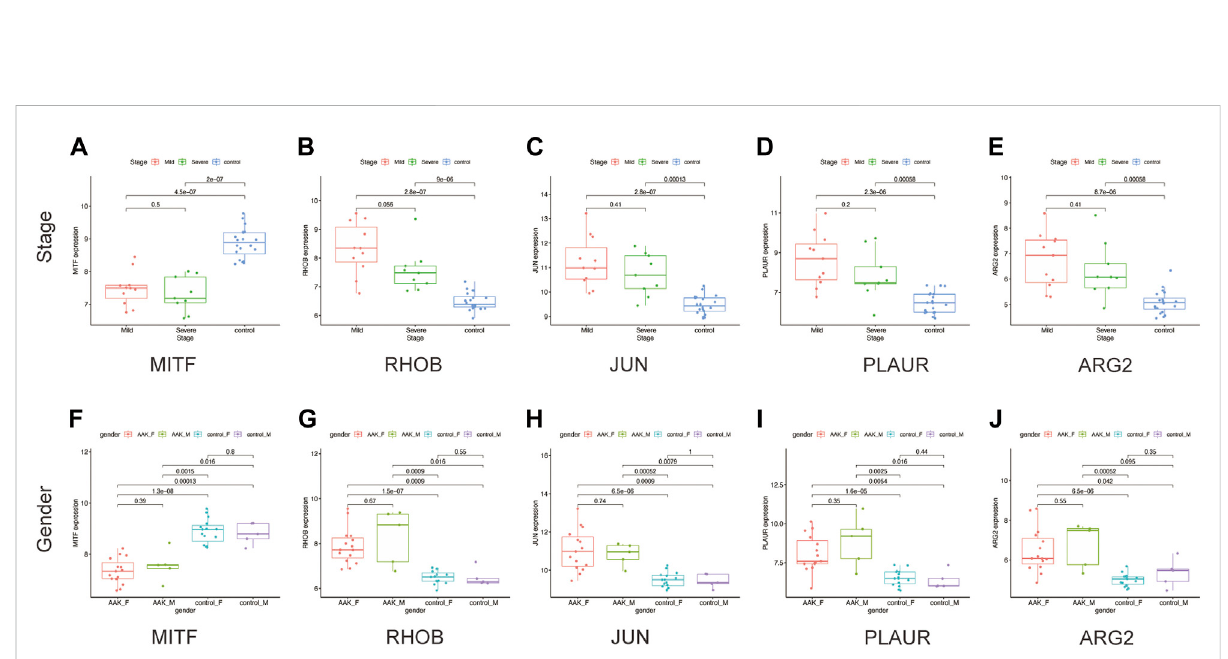
FIGURE 9 The clinical characteristics of hub genes. (A – E) The expression of fi ve hub genes in different stages. (F – J) The expression of fi ve hub genes in males and females between AAK and control patients.